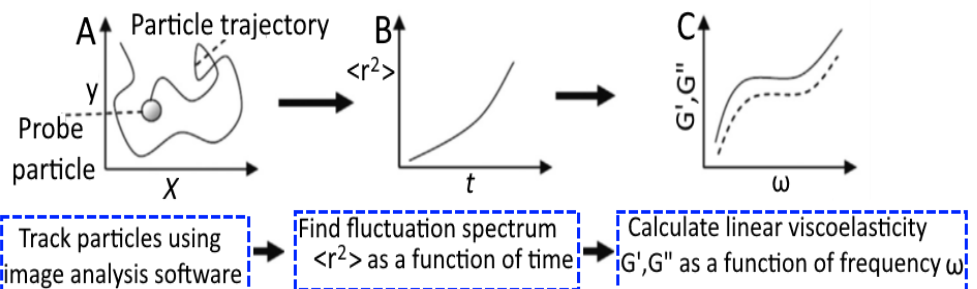
Figure 5. The linear viscoelasticity of low-modulus materials extracted from the fluctuation spectrum using particle-tracking microrheology. ( A ) The probe particle’s trajectory is calculated; ( B ) the spectrum of average fluctuations is computed as a function of time (t (cid:48) ); and ( C ) mechanical spectrum in the linear viscoelastic region (LVER). Figure 5 is reprinted with permission from Nazir et al. [8] (Copyright © 2017 Elsevier Ltd., Amsterdam, The